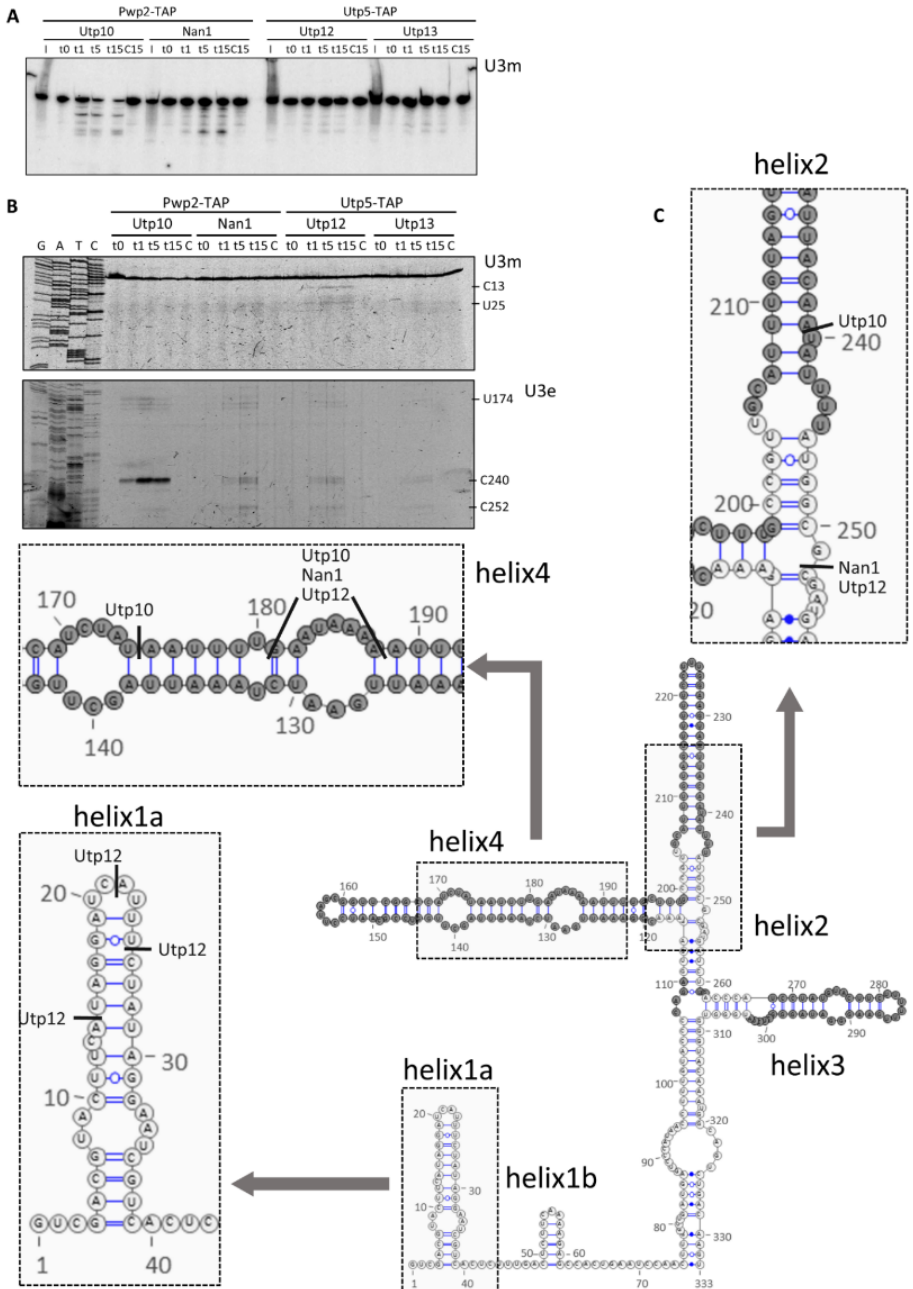
Figure 6. Structural probing of the U3 snoRNA with tethered MNase. Pwp2-TAP (for Utp10-MNase and Nan1-MNase) and Utp5-TAP (for Utp12-MNase and Utp13-MNase) containing pre-ribosomal particles were bound to IgG-Sepharose beads. After purification, MNase was activated by addition of CaCl 2 , and samples were incubated at 16 ◦ C during a time course. At indicated time points, the reaction was stopped, and RNAs were obtained by hot-phenol extraction, resolved in acrylamide gels, and transferred to membrane for northern blot analysis ( A ) or explored by primer extension using fluorescent oligonucleotides ( B ). ( C ) Stops in the reverse transcription observed in B were plotted in the schematic representation of the U3 snoRNA (according to [14,15]). Components of the UTP complexes fused to either TAP or MNase are indicated on top, probes used for detection of RNAs in the northern blot are indicated below the panels, and probes used for primer extension are indicated at the left of the panels. Some nucleotides at prominent stops are indicated on the right